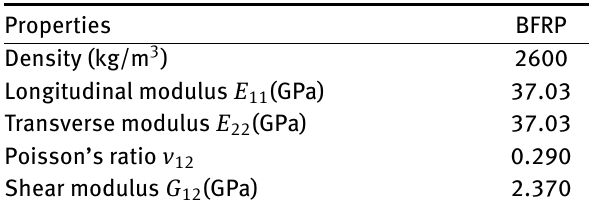
Table 2: Mechanical properties of